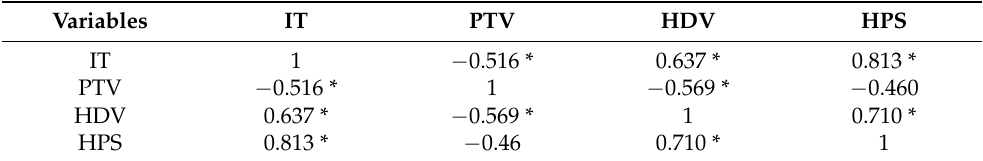
Table 4. Spearman’s rho correlation coefficient for hypothesis